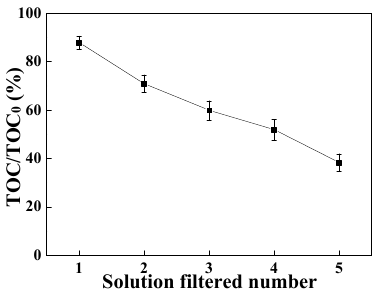
Figure 7. TOC removal of BPA in ZFP/PMS system ([BPA] 0 = 0.02 mM, flow rate = 5mL/min).